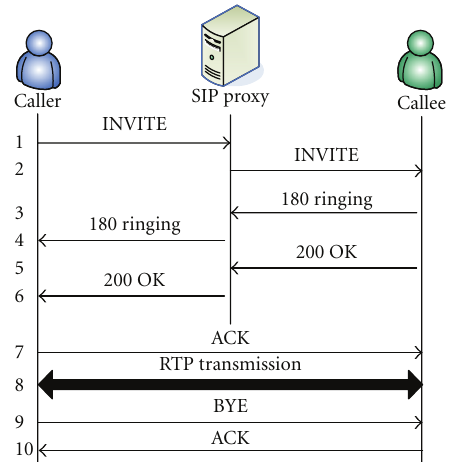
Figure 2: Basic operations of VoIP session via SIP signaling. payload from source MA (sMA) to destination MA (dMA). Then, dMA can use this common secrete key to decrypt the encrypted RTP payload.